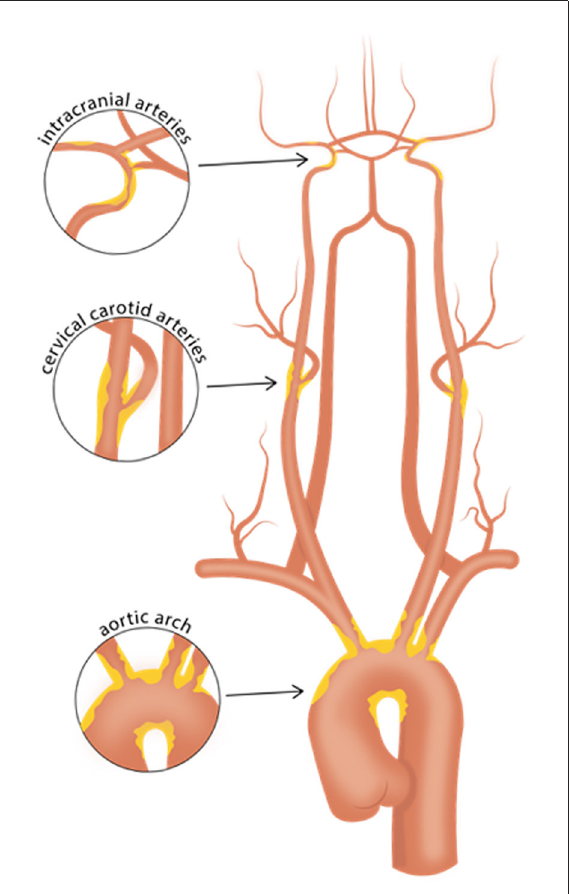
FIGURE1 Vascular beds commonly affected with atherosclerosis. Careful evaluation of high-risk plaque features using vessel wall MRI of the intracranial arteries, cervical carotid arteries, and aortic arch may aid in identifying culprit plaques in patients with cryptogenic stroke or embolic stroke of undetermined source. Such efforts may help identify causes of stroke that may have been previously